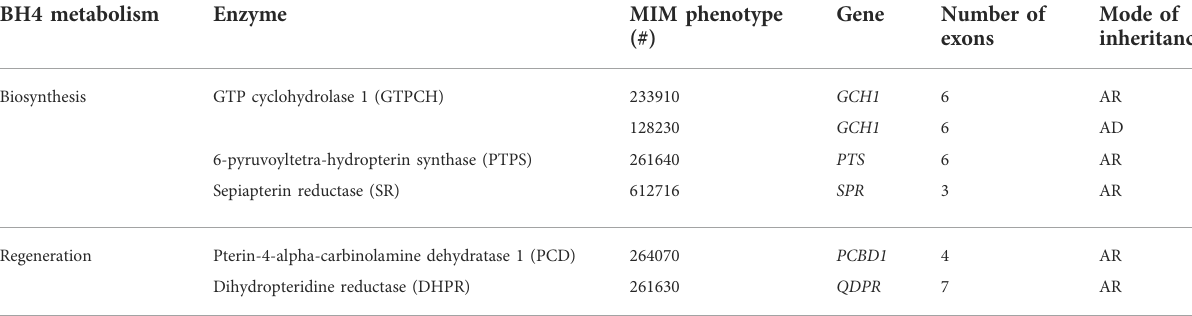
TABLE 1 Genes and enzymes involved in BH4 metabolism